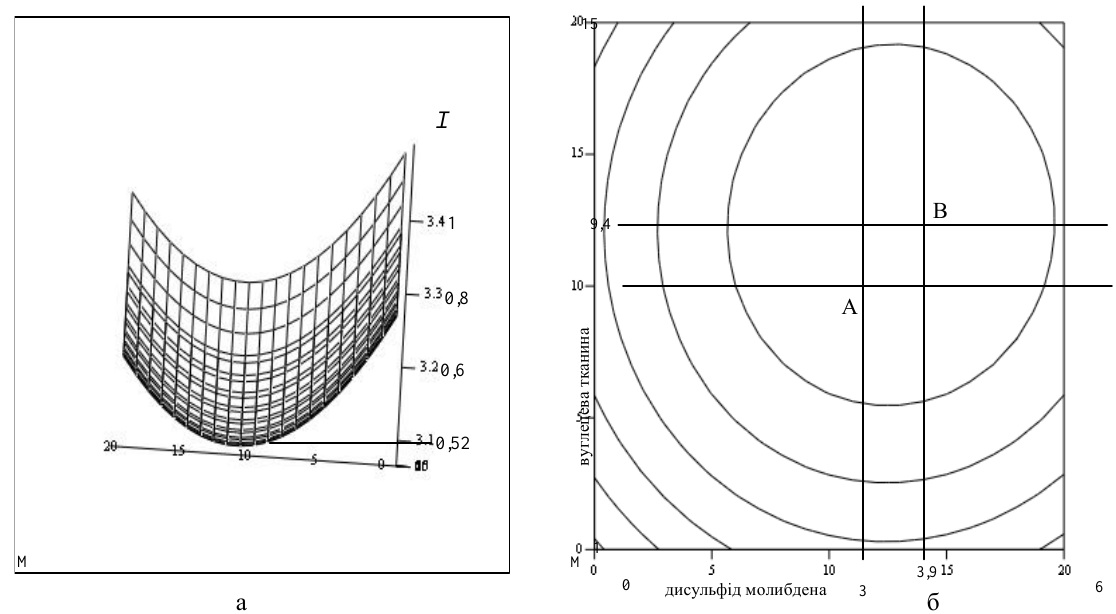
Fig. 11 - Graphical interpretation of the mathematical model of wear intensity (a) and two-dimensional section of the function f (Xi, Yi, Zi) at Zk = 0.